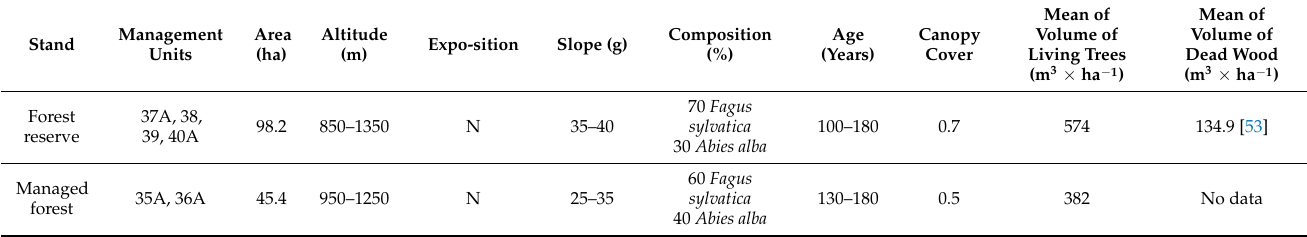
Table 1. Forest stand characteristics (taken from the forest management plan [51] ).